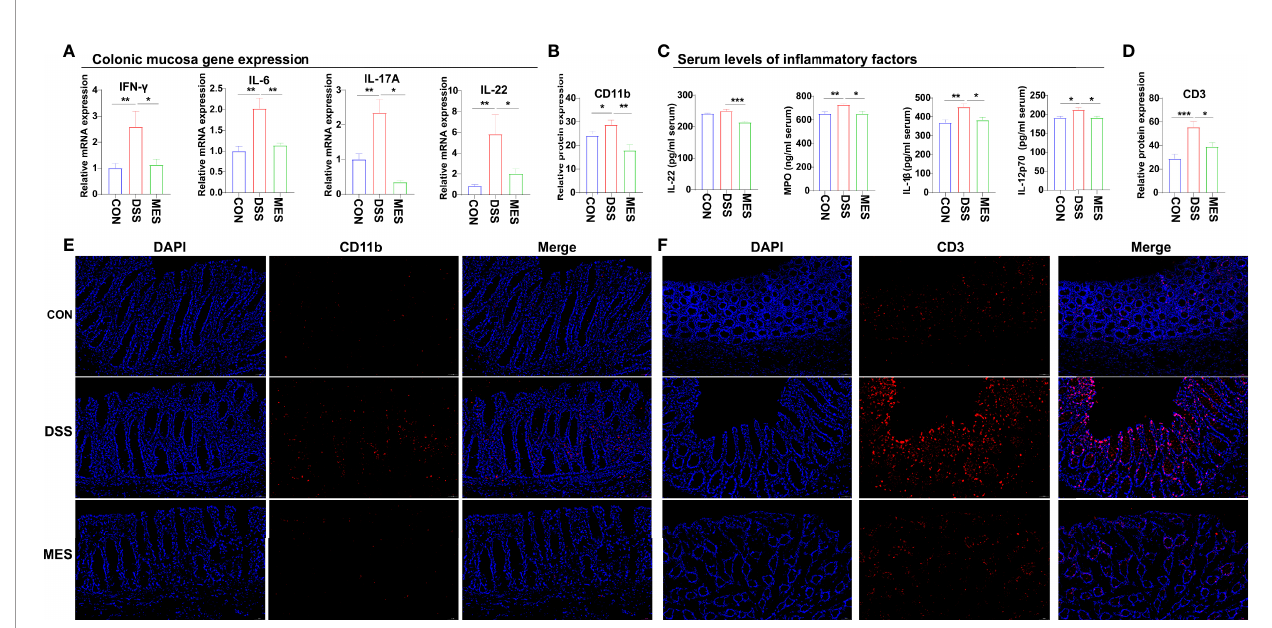
FIGURE 3 | MES reduces the recruitment of immune cells in piglets with DSS-induced colitis. (A) Colonic mucosa mRNA levels of IL-6, IL-17A, IL-22, and IFN- g ; (B, D) intestinal frequencies of CD11b + macrophages and CD3 + T cells; (C) serum levels of MPO, IL-1 b , IL-22, and IL-12 p70; (E, F) representative images of intestinal in fi ltrations of CD11b + myeloid cells and CD3 + T cells. Scale bar = 50 µm. Data were presented as mean ± SEM (n = 6 per group). Statistical signi fi cance was determined using one-way ANOVA, followed by Tukey test. * P < 0.05, ** P < 0.01, *** P <